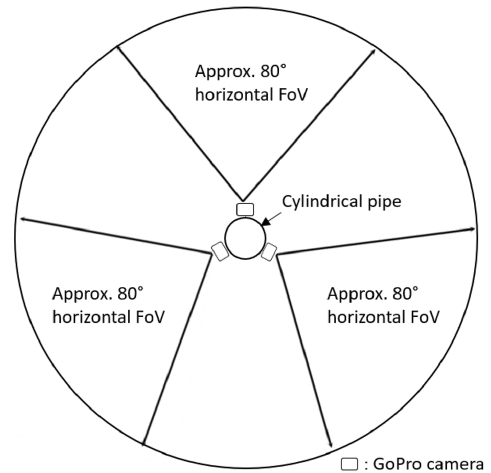
Fig. 3. Simplified sketch of the top view of the video moni- toring equipment. Approximately 2/3 of the circular angle was covered by the 3 GoPro cameras. FoV: field of view